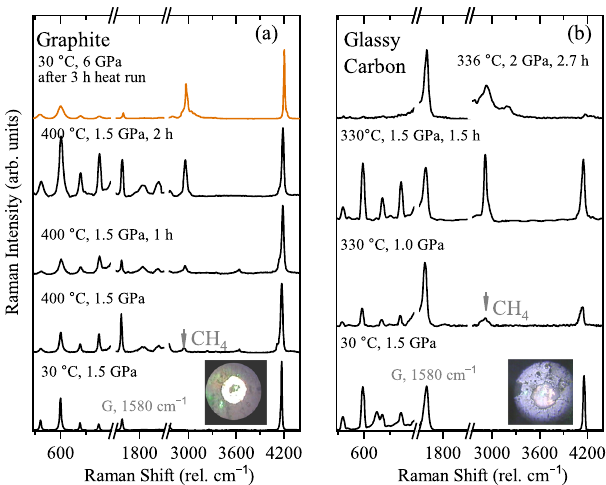
Fig. 4 Resistive heating of hydrogen in a diamond anvil cell. a Graphite loaded together with H 2 , spectra at selected temperatures and pressure. Spectra have been normalized to the H 2 stretching mode, around 4200cm − 1 . Orange spectrum correspond to the quenched sample. b Glassy-like carbon loaded together with H 2 , spectra are normalized to the G band characteristic of carbonaceous materials at around 1580cm − 1 . Inserted images correspond to the sample within the diamond anvil cell chamber during the